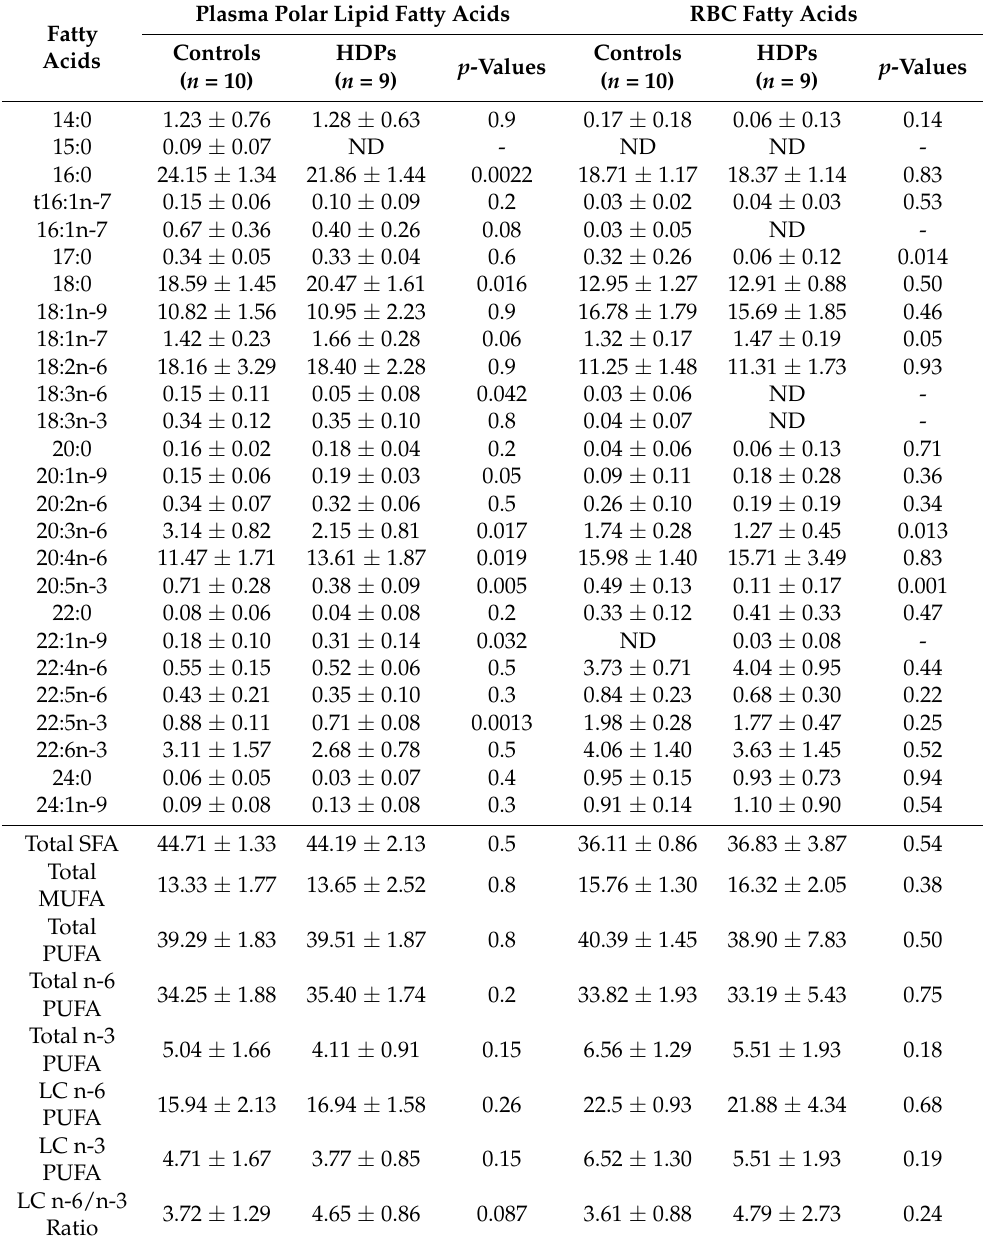
Table 1. Plasma fatty acid percent composition of polar lipids and RBCs in female healthy control subjects and female hemodialysis